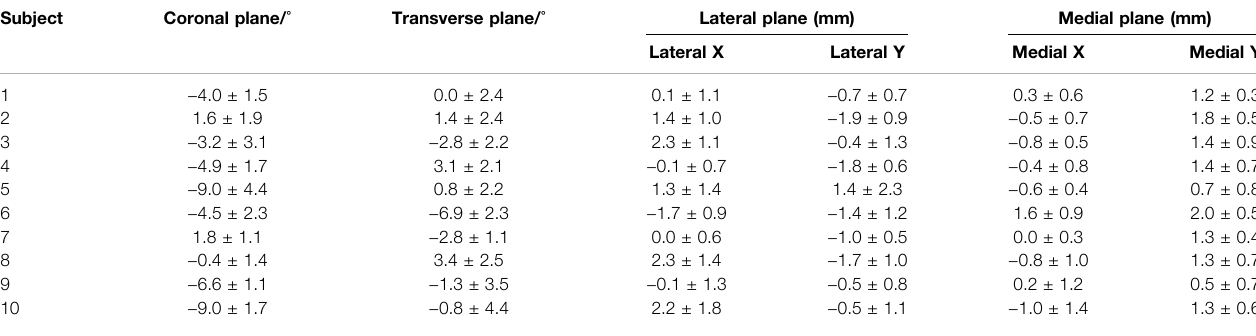
TABLE 1 | Mean fl exion axis (MFA) position in the coronal, transverse, lateral sagittal, and medial sagittal planes. Positive inclination indicated that MFA was varus and internally rotated to the medial – lateral epicondyle axis (MLA). In the lateral and medial planes, positive values indicated that the MFA was anterior and proximal to the center of the